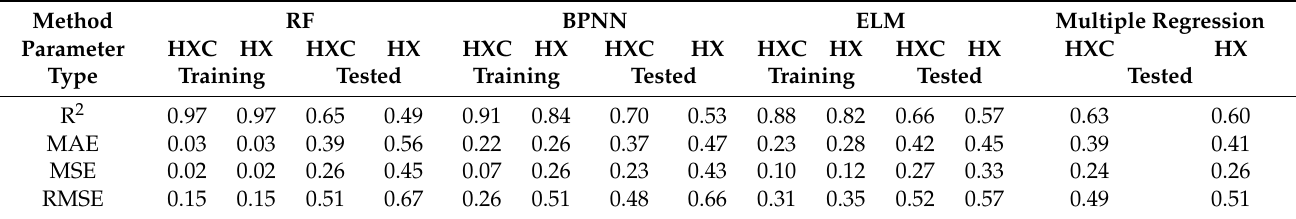
Figure 7. Cross plots between TOC values from multiple regression models and TOC values from core data. Table 4. Mean error values of different